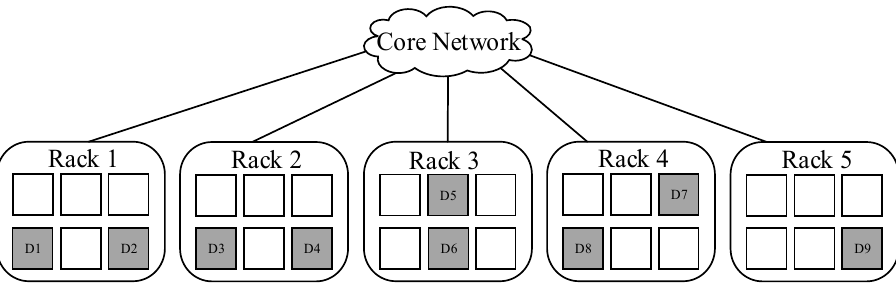
Figure 3. A kind of placement across 5 racks ( c = 2).